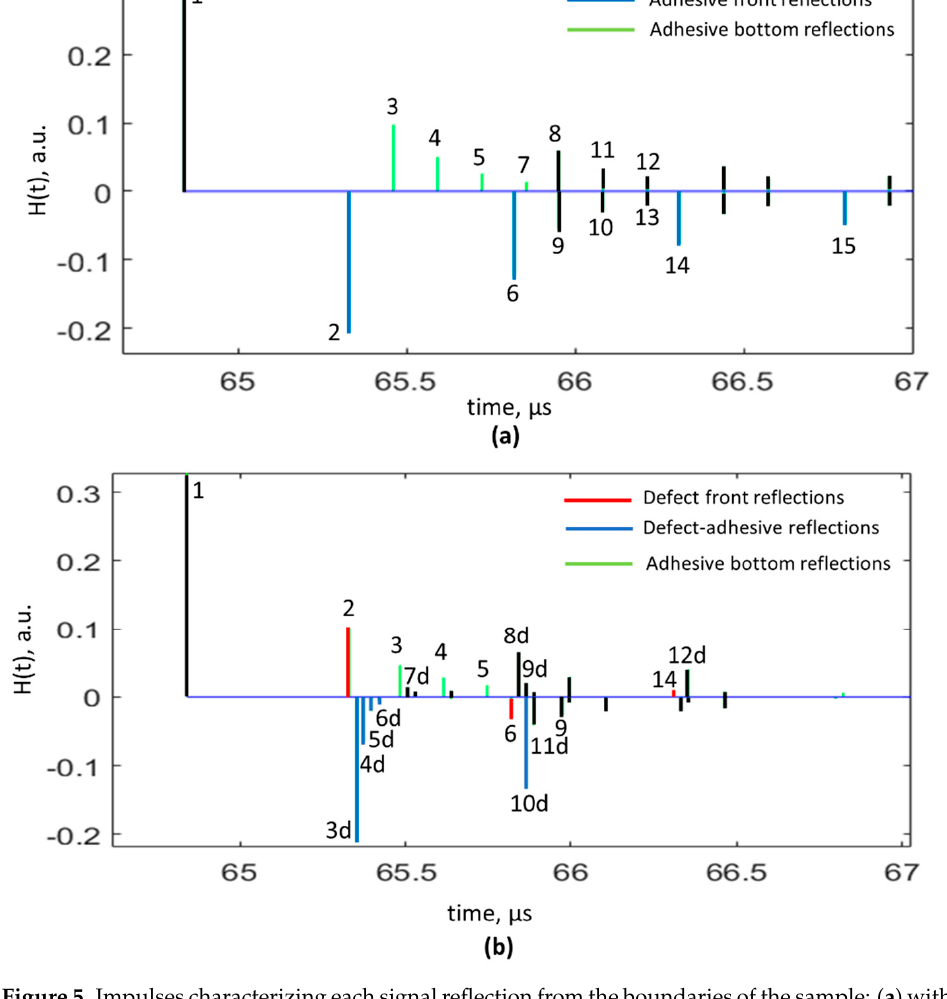
Figure 5. Impulses characterizing each signal reflection from the boundaries of the sample: ( a ) without defect; ( b ) with defect.